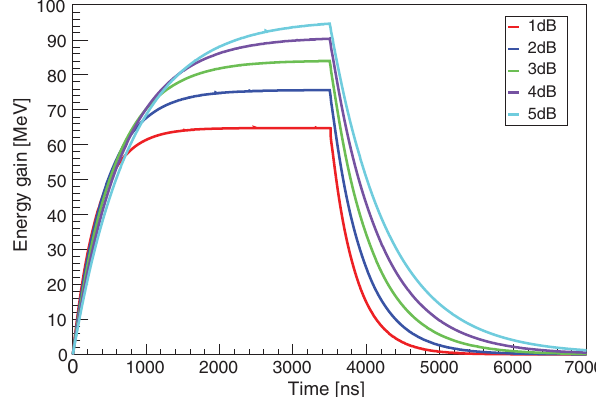
FIG. 4. Time dependence of the energy gain in the resonant ring for different coupling constants.